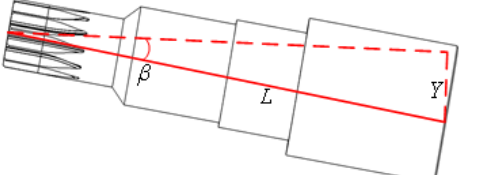
Figure 6. Input and output shaft tilt model.